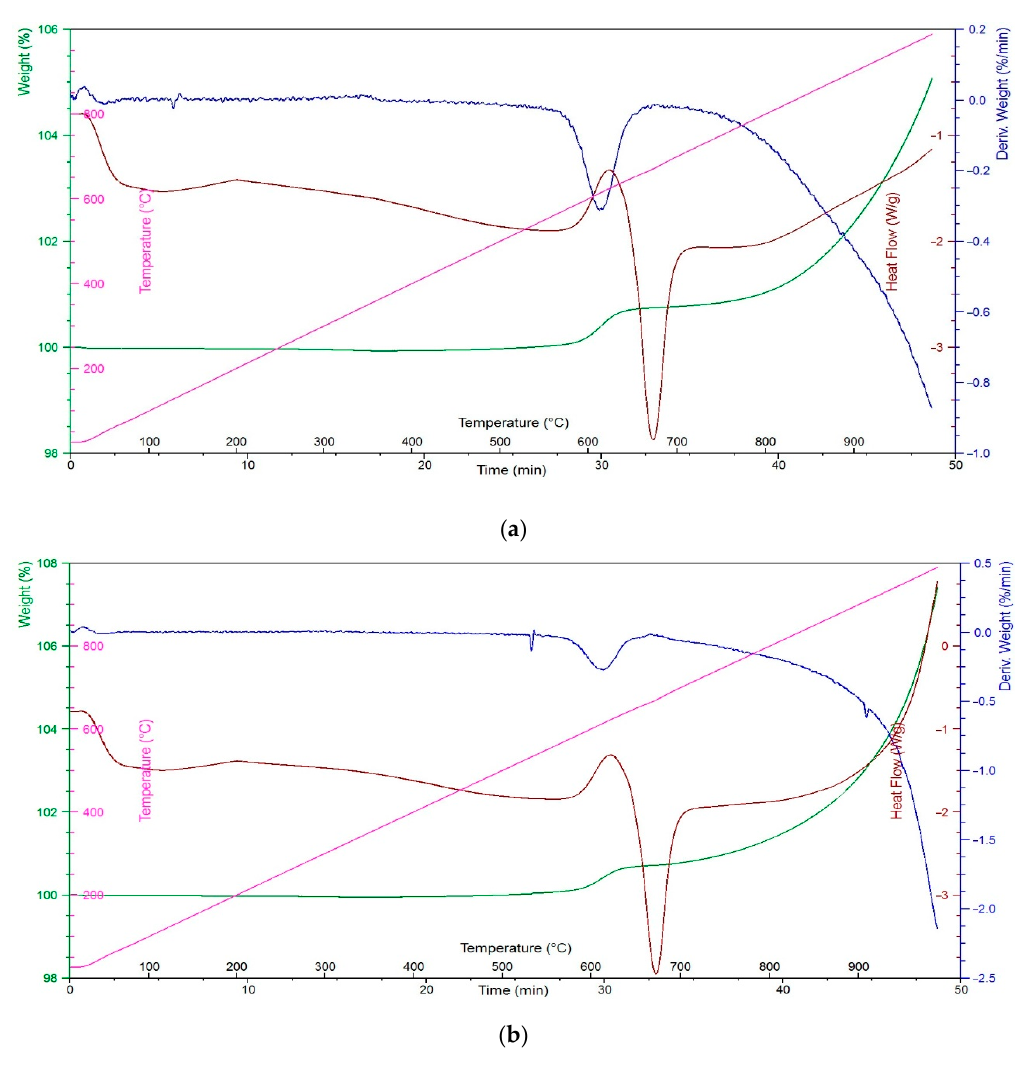
Figure 8. TG–DSC analysis of ASP-30 powder: ( a ) before electrostatic classification; ( b ) after electrostatic classification with 30 kV voltage applied .